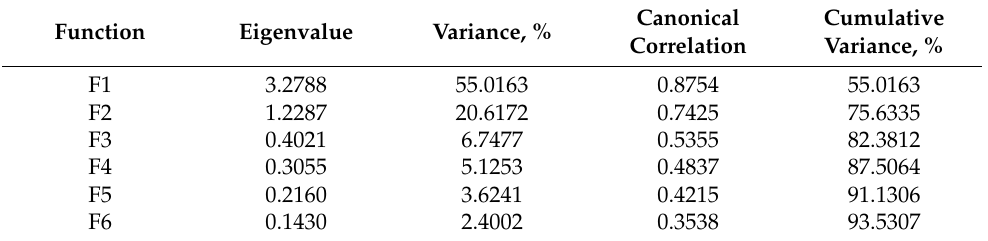
Table 5. Canonical variable functions and percentages of self-explained and cumulative variance.